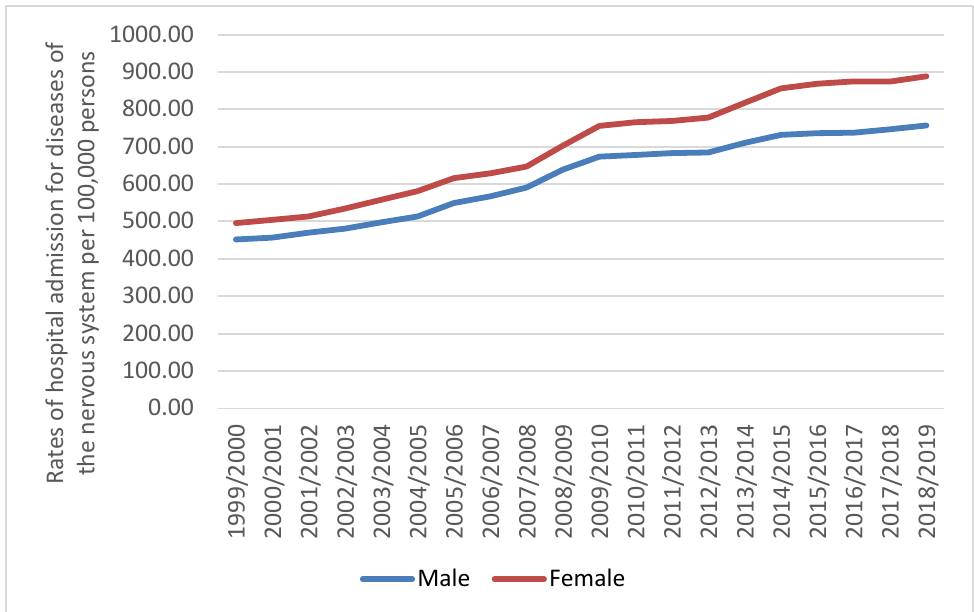
Figure 3. Rates of hospital admission for diseases of the nervous system in England and Wales stratified by gender.